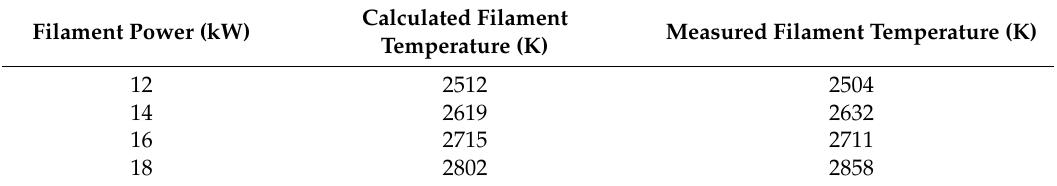
Table 2. Calculated and measured temperatures of filaments according to applied power.